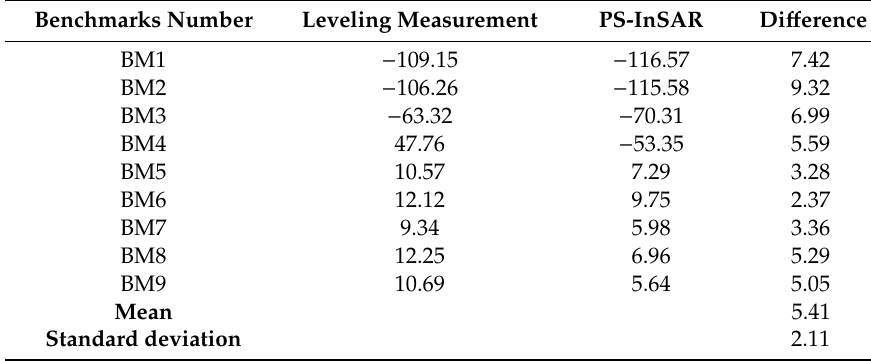
Table 4. Comparison of land subsidence results by PS-InSAR technique with leveling measurement (mm / year).